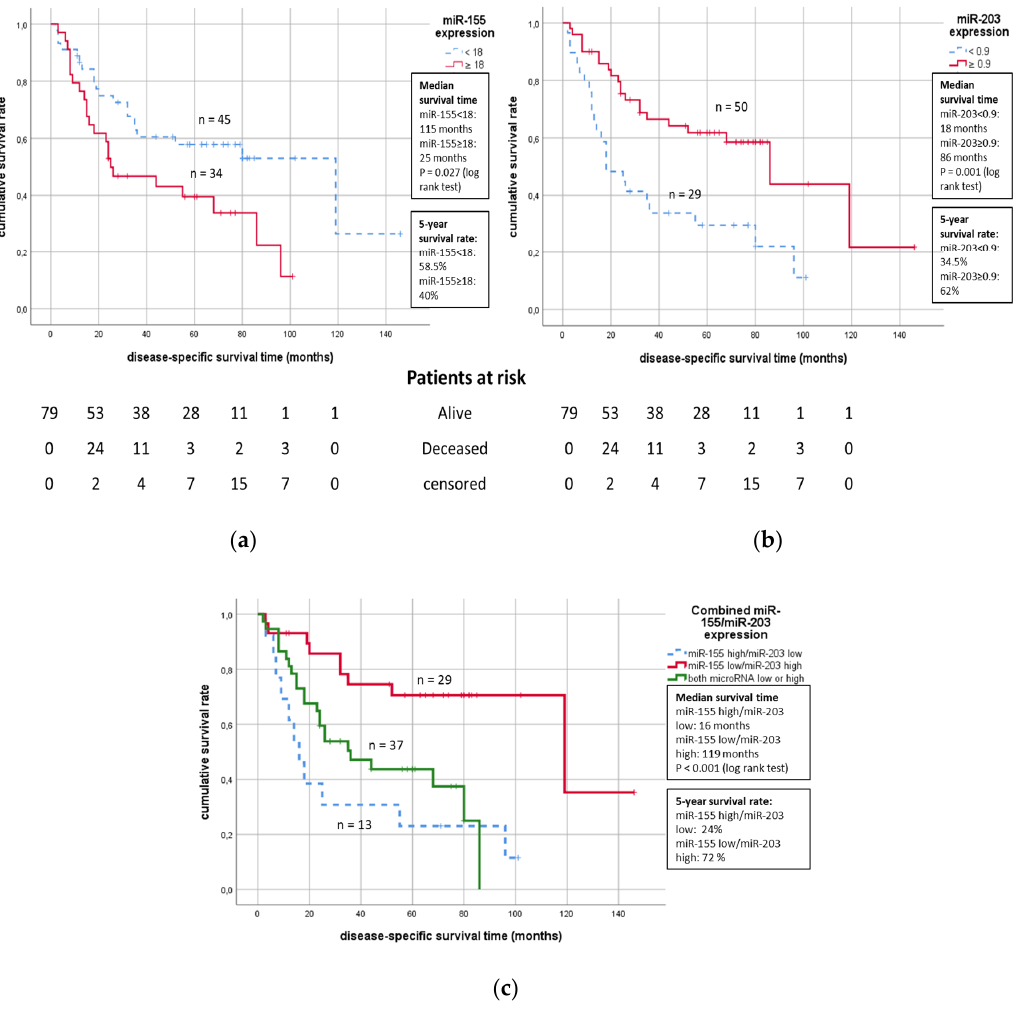
Figure 4. Kaplan-Meier survival analyses of the prognostic impact of miR-155 ( a ) and miR-203 ( b ) expression or a combination of both microRNAs ( c ) on soft tissue sarcoma patient survival. Below the figures, the number of patients at risk at specific time points is given.